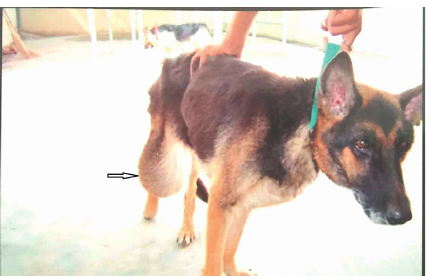
Figure 1: Inguinal mammary tumor (hanging in the inguinal region) in a 11-year-old German shepherd dog.